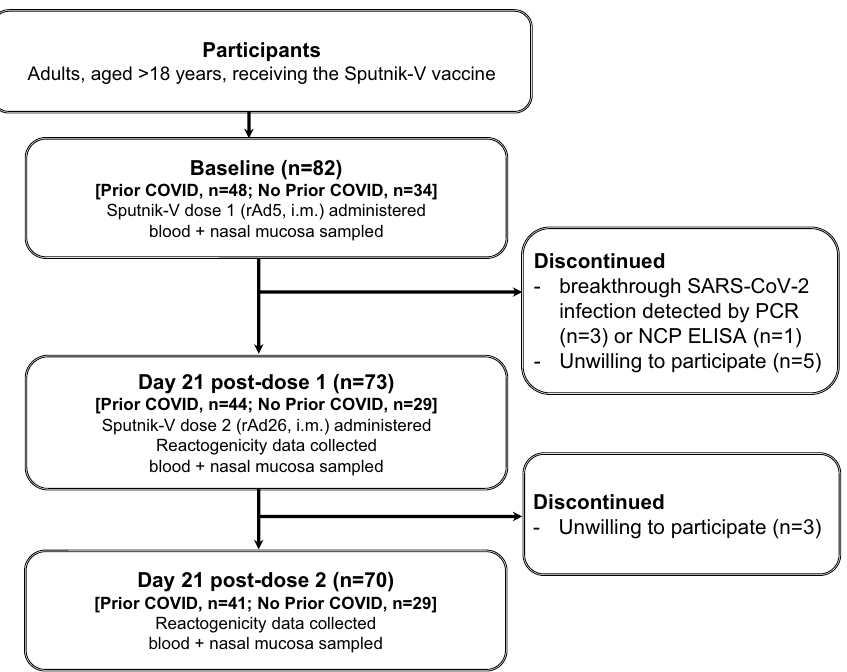
Figure 1. Screening and recruitment flow chart. See the Methods for detailed study inclusion criteria. rAd recombinant adenovirus, i.m. intramuscular, NCP nucleoprotein.